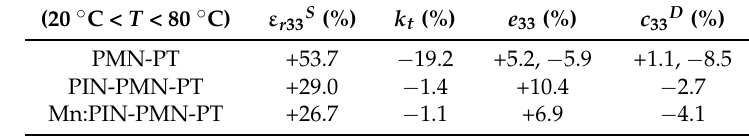
Table 2. Variation with T for three generations of piezocrystals, 20 ˝ C ď T ď 80 ˝ C (Reference T = 20 ˝ C).